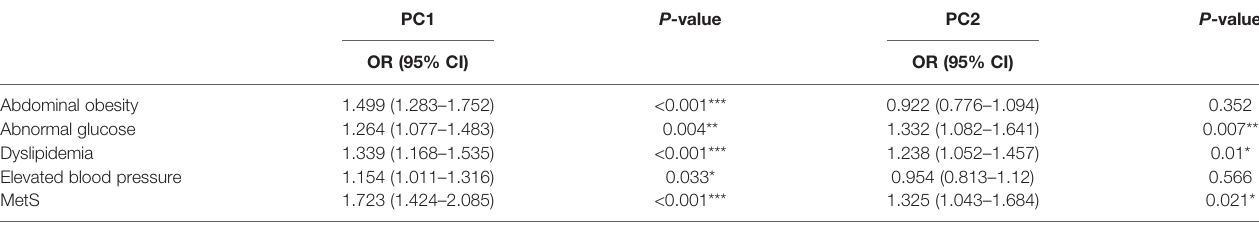
TABLE 5 | The odds ratios for abdominal obesity, abnormal glucose, dyslipidemia, elevated blood pressure, and MetS adjusting for additional factors.